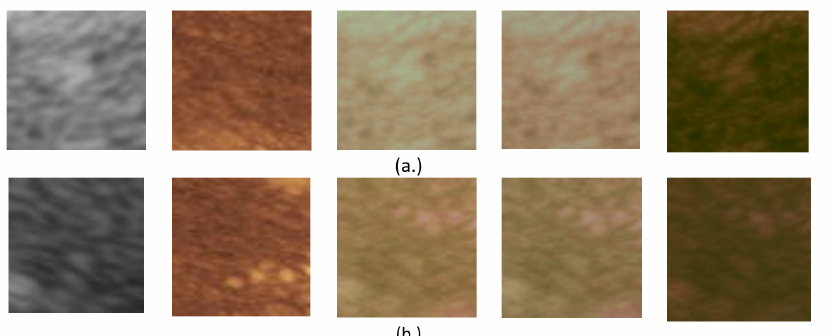
Figure A1. Examples of ( a. ) HCC and ( b. ) PAR patches, in the following cases (left -> right): the B-mode ultrasound image; the CEUS image; the arithmetic mean of the B-mode ultrasound and CEUS images; the weighted mean of the B-mode ultrasound and CEUS images; the multiplication between the B-mode ultrasound and CEUS images.